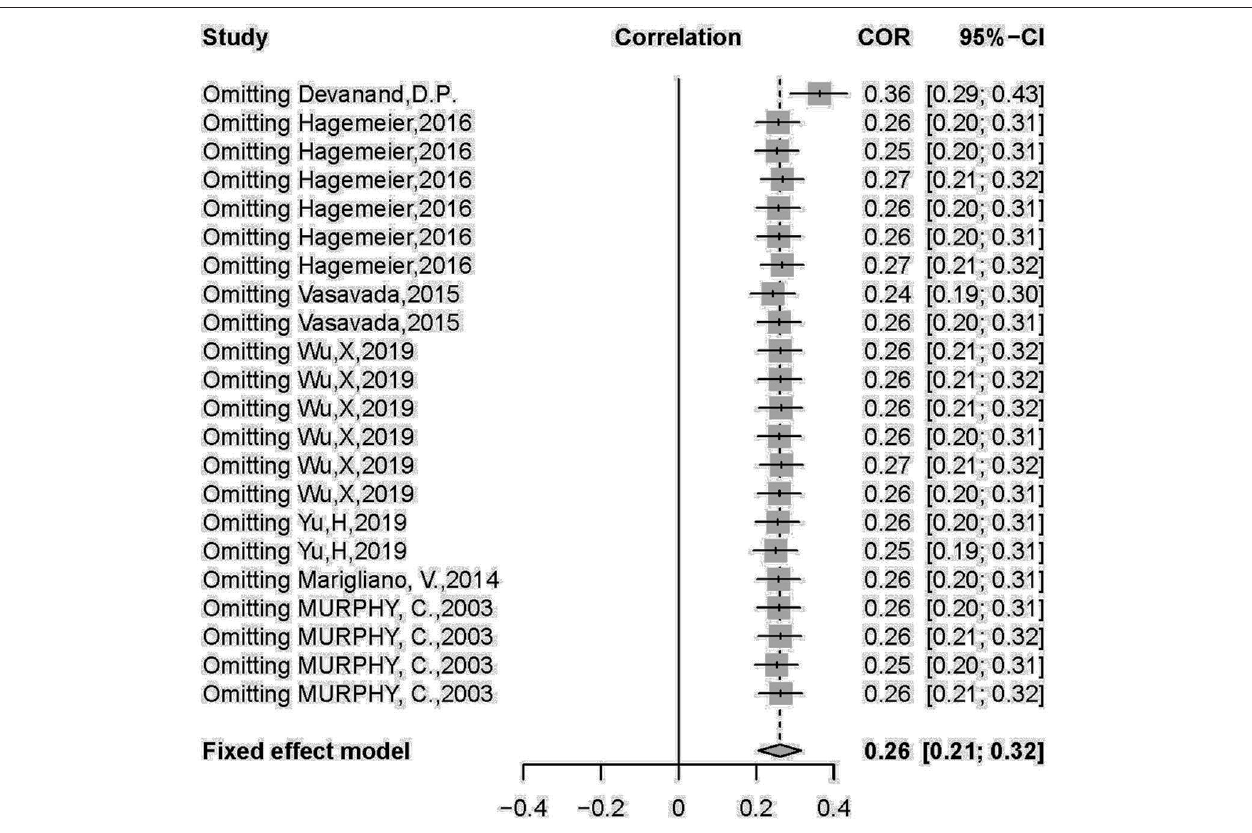
FIGURE 3 | Sensitive analysis in leave-one-out